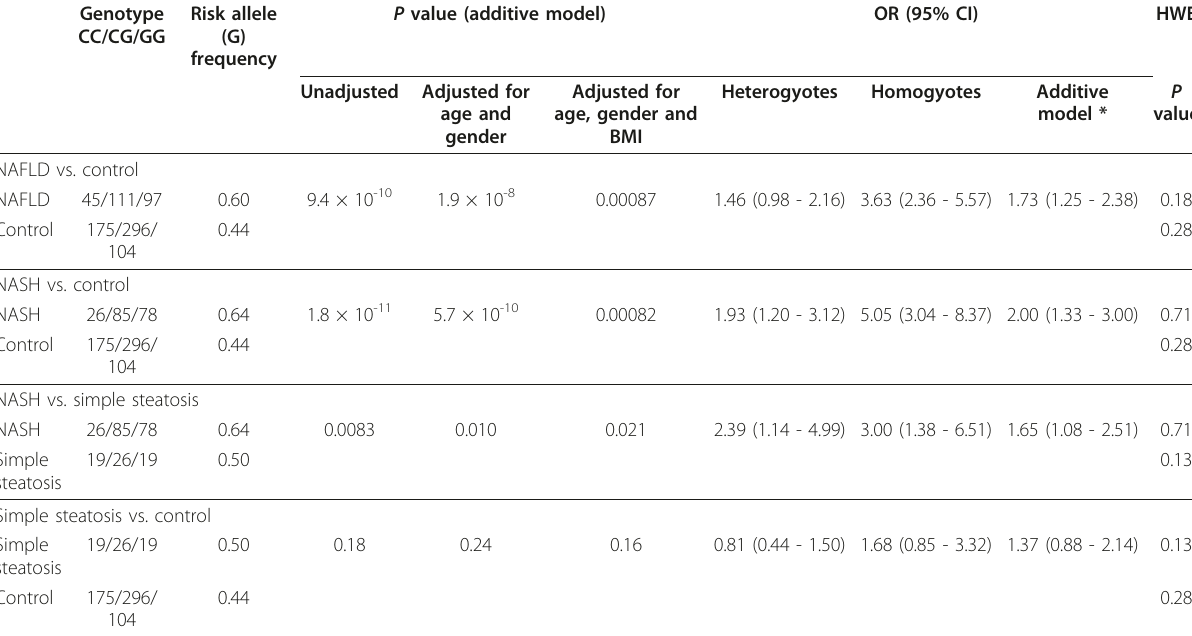
Table 3 Genotype frequencies and association tests of rs738409 in PNPLA3 in patients with NAFLD and control subjects